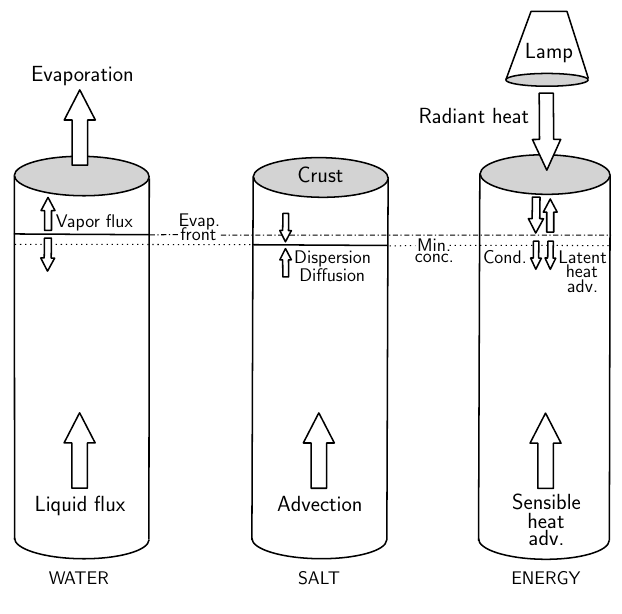
Fig. 1. Diagram of the design of the evaporation column experi- ments and their conceptual model from day one (saturation) to the end of the experiment (oven dry conditions). The water fluxes are on the left, the salt fluxes are on the center and the energy ones on the right. The dashed and point lines show the location of the evap- oration front and the minimum in salt concentration